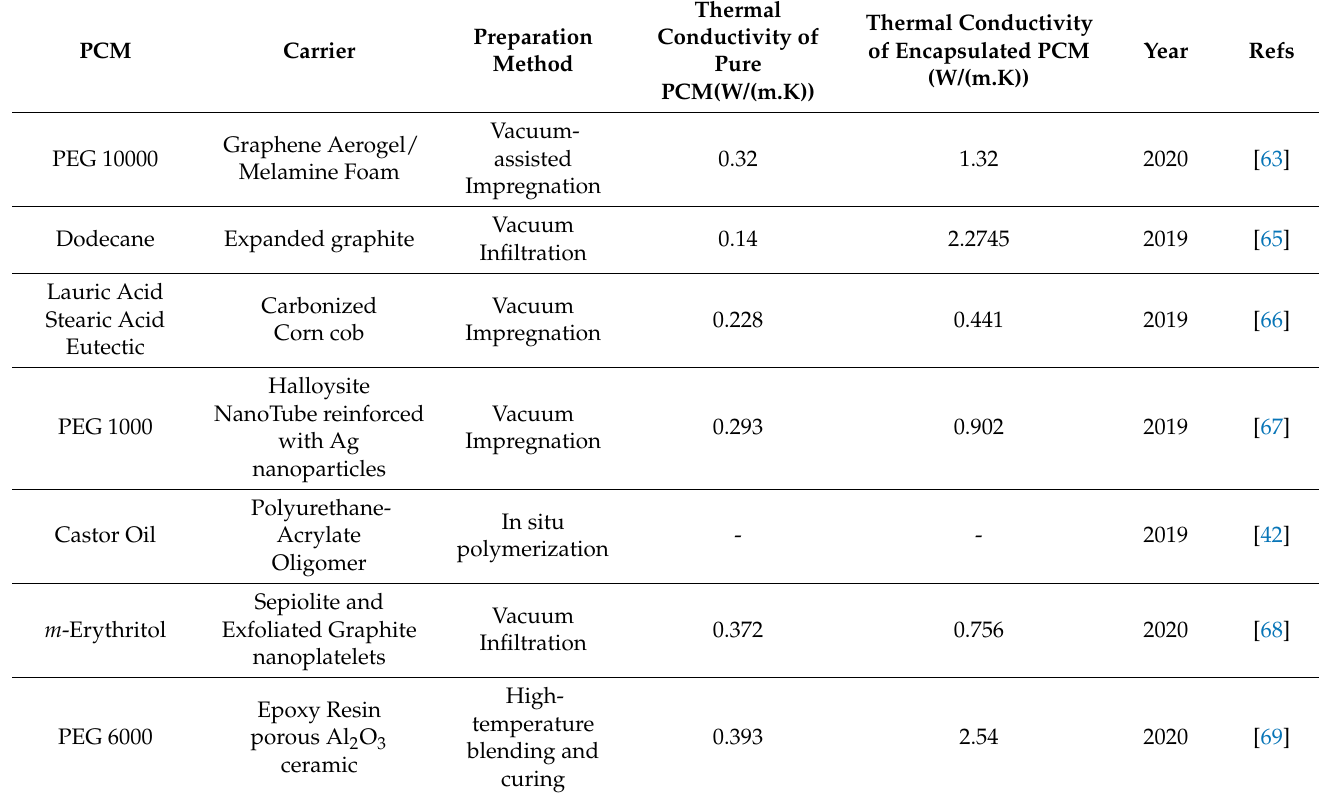
Table 6. Recent applications of form-stable composites